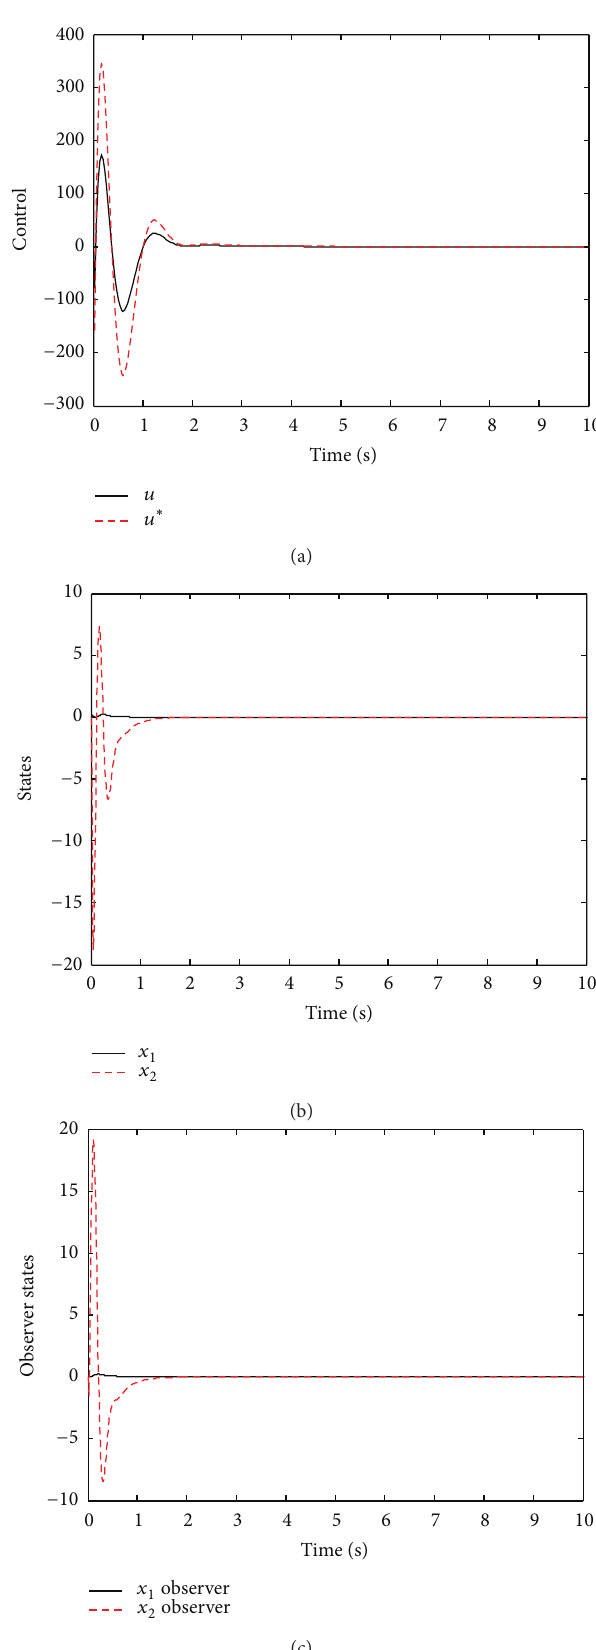
Figure 2: The responses of the closed-loop systems (49) ∼ (53) when adopting the method in [19,